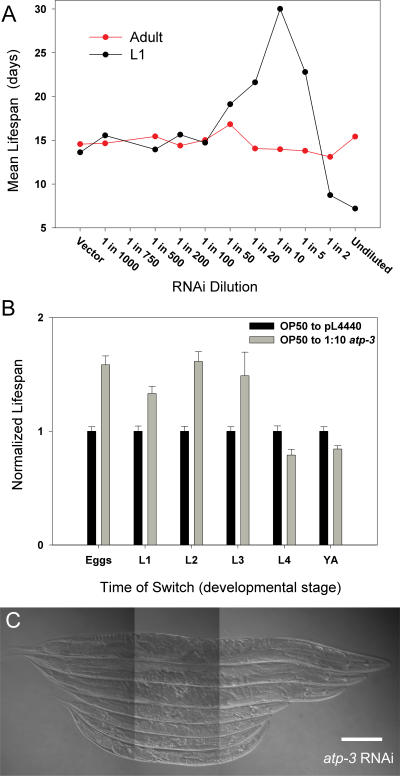
A Larval Signal Triggers atp-3 Life Extension(A) A synchronous population of N2 was exposed to an atp-3 RNAi dilution series either from the time of hatching (black line) or 3 d later after progression to 1-d-old gravid adulthood (red line). Life extension was evident only in animals exposed to atp-3 RNAi from the time of hatching.(B and C) A synchronous population of N2 was cultured on a standard OP50 bacterial lawn. Worms representing each stage of development, (larval stages L1 to L4, and young adults [YA]), were transferred to vector control or 1:10 atp-3 RNAi plates (n = 60/condition). The effect of atp-3 RNAi on adult lifespan (B) and final adult size (C) is shown. Lifespan data are normalized relative to the vector control for each larval stage. Normaski image in (C) is of 2-d-old adult worms (400×): bottom to top: egg, L1, L2, L3, L4, and YA on 1:10 atp-3 RNAi. The top animal was transferred to vector control as a YA. Scale bar indicates 100 μm.